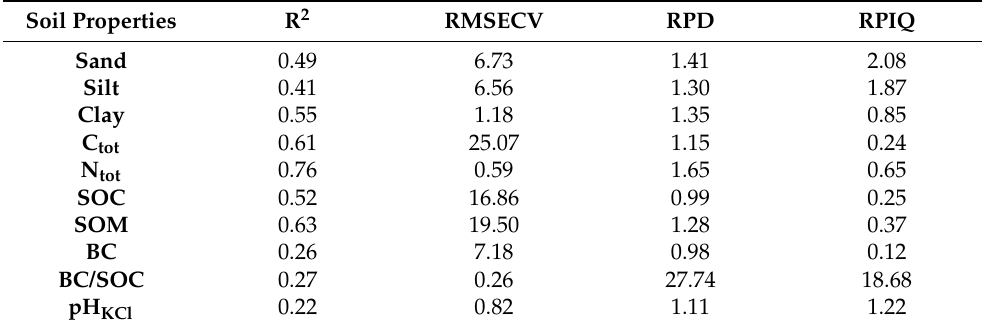
Table 2. Results of the cross-validated prediction for the investigated soil properties using SVM